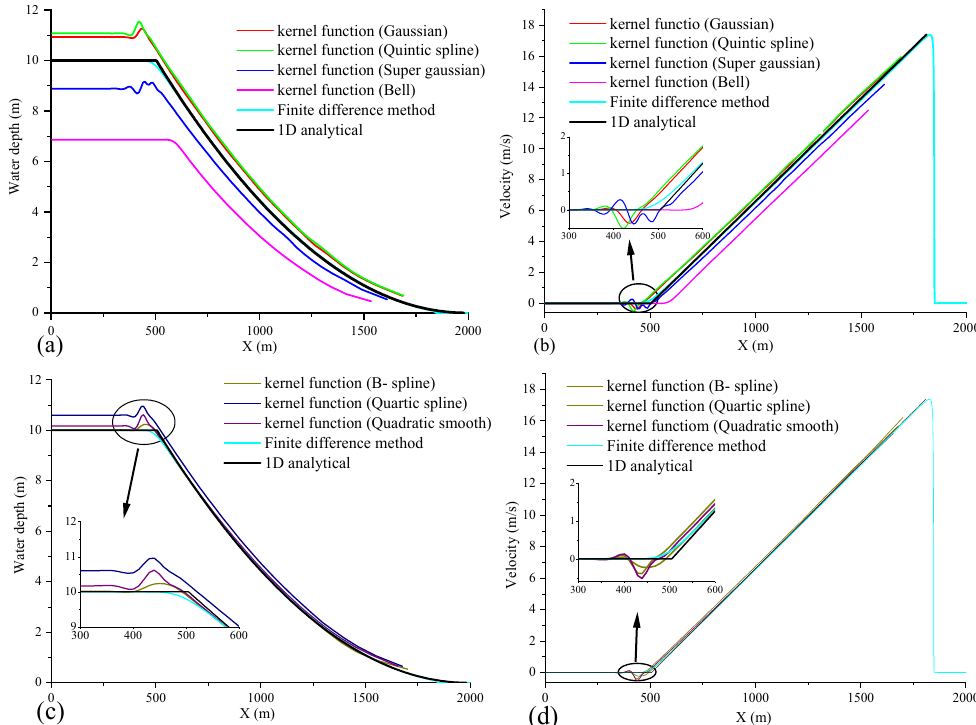
Figure 1. Simulation results of different kernel functions. ( a ),( c ) Results of water depths calculations. ( b ),( d ) Results of velocity calculations.